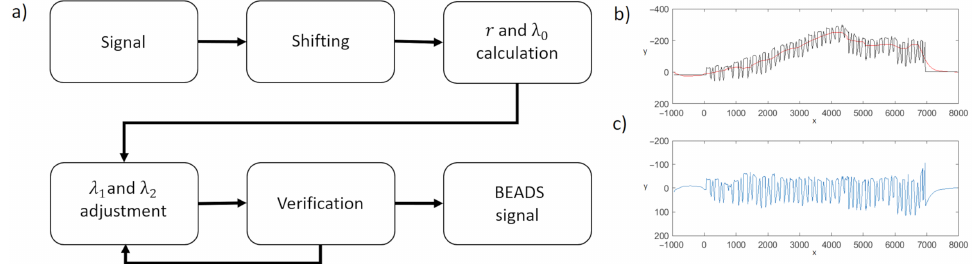
Figure 3. ( a ) Baseline estimation algorithm. ( b ) The processed signal (black) and the calculated baseline (red). ( c ) The signal after baseline